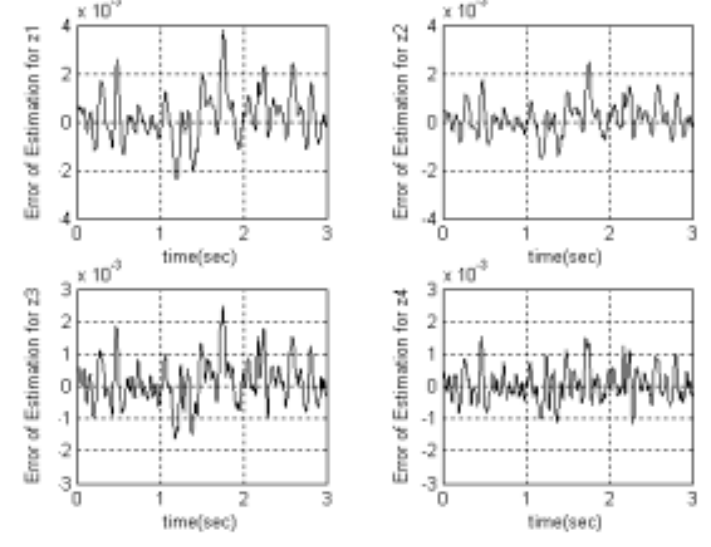
Fig. 3. Error of the estimation for the first four